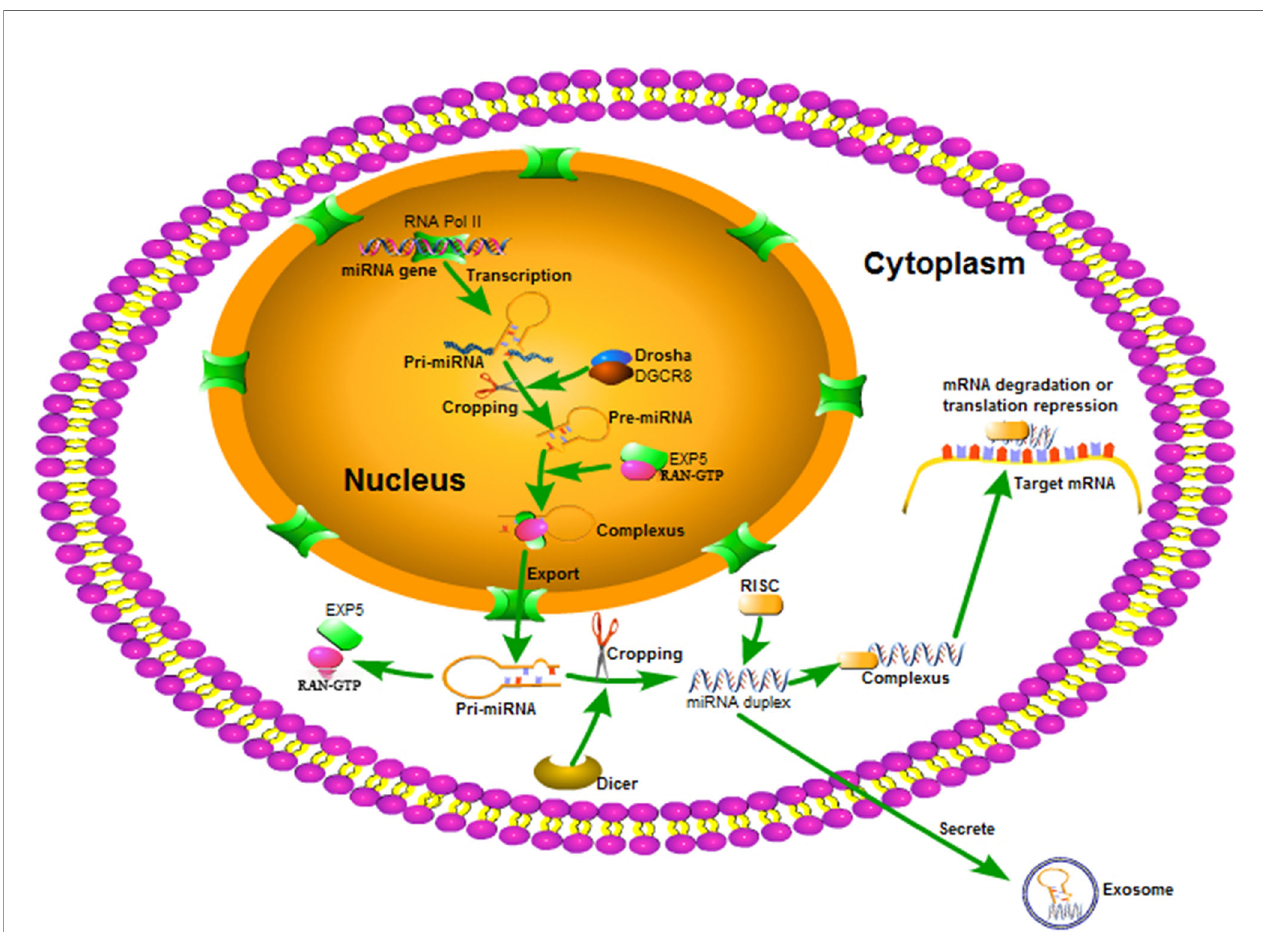
FIGURE 1 | The biosynthesis and maturing process of miRNA. miRNA is transcribed as a single pri-miRNA with the help of RNA Pol II, and is then cropped into a hairpin-structured pre-miRNA through the DGCR8 complex in the nucleus. Exportin 5 and RAN-GTP aid to transferring the pre-miRNA to the cytoplasm. In the cytoplasm, pre-miRNA is processed into a miRNA duplex by the Dicer complex. One strand of the miRNA duplex bonds to RISC and guides it to various mRNA targets to regulate gene